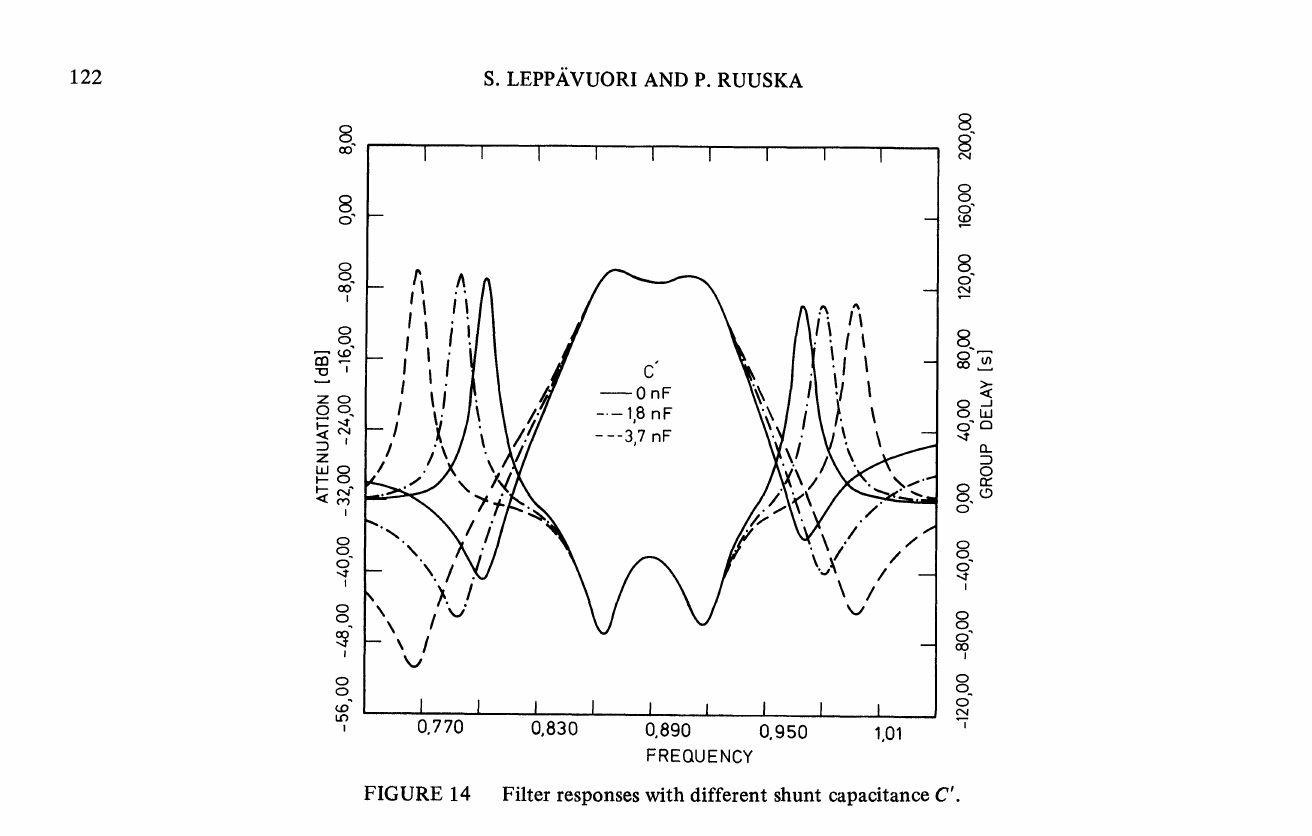
measurements and calculations with different load conductances (PZT-7 A, h 0.62 mm, d 0.35